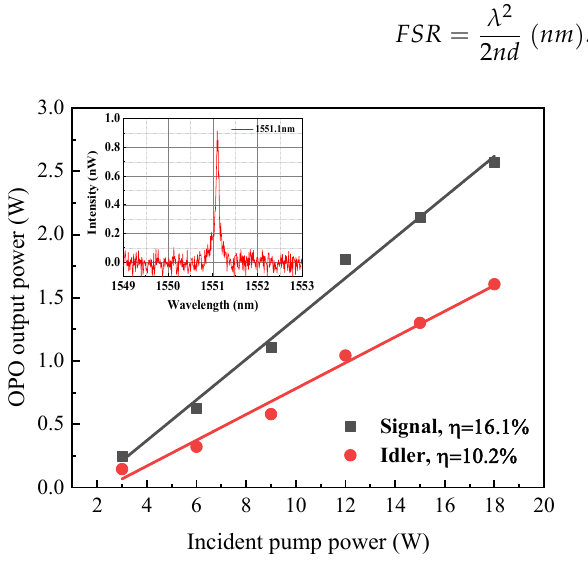
Figure 4. OPO output power versus incident pump power with the F–P etalon. Inset: output spectrum of the signal wave.